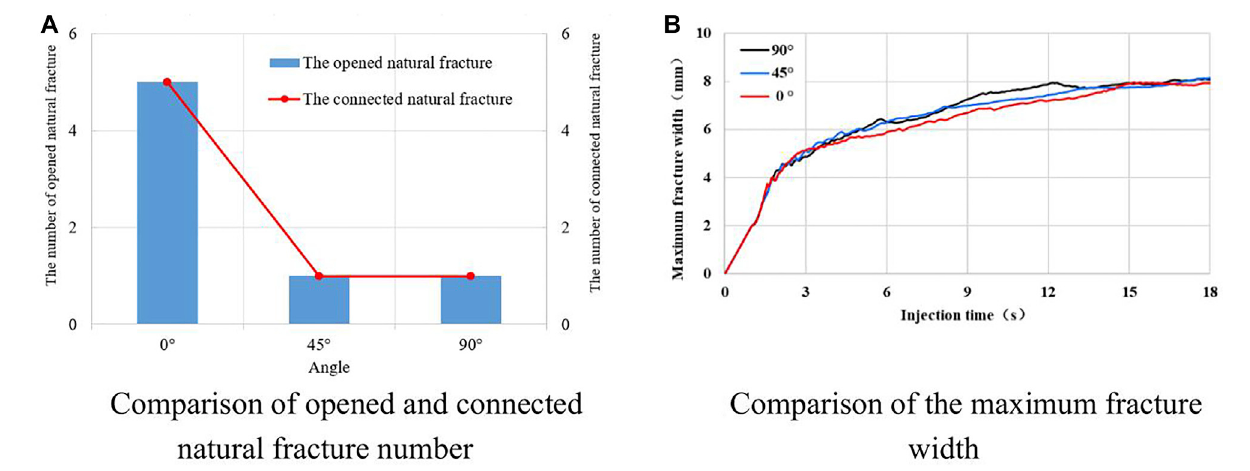
FIGURE 8 | The fracture morphology comparison of different natural fracture angle. (A) Comparison of opened and connected natural fracture number. (B) Comparison of the maximum fracture width.